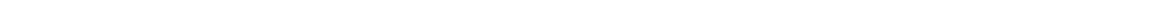
Fig. 3 Protein turnover data are not predictable from accessible transcriptomics data sets on cardiac hypertrophy and heart failure. a Schematic of integrated analysis of the protein turnover and protein abundance data from the six mouse strains alongside 29 sets of the publicly accessible transcriptomics data on NCBI Gene Expression Omnibus (GEO). b Summary of retrieved data sets. Accession: accession number of the NCBI GEO data set. Model: experimental model to induce cardiac hypertrophy — TAC, transverse aortic constriction; MI, myocardial infarct; ATII, angiotensin II stimulation; ISO, isoproterenol stimulation. Time: days of experimental model at sample collection. Species: Mm, Mus musculus . Strain: Genetic background of the animals studied — Mu, multiple strains. Tissue: cardiac tissues collected for pro fi ling — LV, left ventricle; H, whole heart; V, whole ventricle. Sex: gender of animals — M, male; F, female; ND, not determined/reported. c Each cell in the matrix is a pairwise comparison between two data sets. Color denotes the strength of robust biweight midcorrelation between the resulting signature lists (ratio of disease/control) between the compared data sets. Transcript abundance data sets (green labels) show appreciable correlation with one another but not protein abundance (blue labels) and turnover (red labels) data. d Comparison of gene list rank similarity metrics 48 of the retrieved protein abundance, turnover data, and accessible transcriptomics data sets. Solid squares: signi fi cant protein list order similarities between two data sets ( P < 0.05). e Normalized log ratio ( y -axis) of selected proteins across data sets. Hypertrophy markers ANXA2, FHL1 and ANXA3 show consistent differential regulations in all experiments, whereas 22 of 95 examined proteins are implicated in hypertrophy via turnover but have no discernible, or discordant, changes in transcript abundance. Hence over existing transcript data